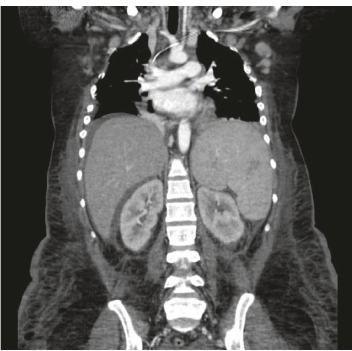
Figure 1: Abdominopelvic CT showing pleural effusions, lymphadenopathies, hepatosplenomegaly, and